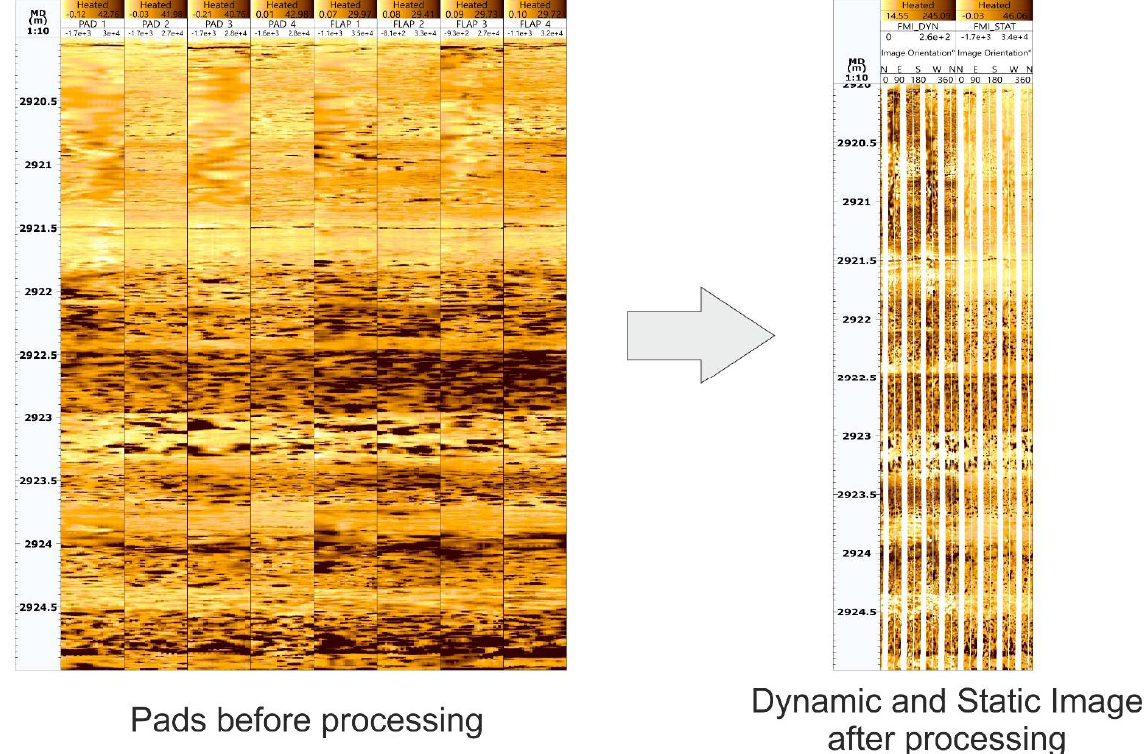
Figure 5. Results of the FMI processing for well A. For static image derivation, each value of resistivity or conductivity is mapped on a scale normalized for the entire interval. Dynamic normalization maps each value to a scale defined by the data range in a sliding window. Therefore, for the dynamic image (FMI_DYN), local contrast is enhanced. Note the increase in resolution on the dynamically processed images, especially above 2921.5 m. Resistive intervals are represented by light yellow shades. Darker shades and spots show the presence of possible pore space, where conductive mud filtrate can enter.